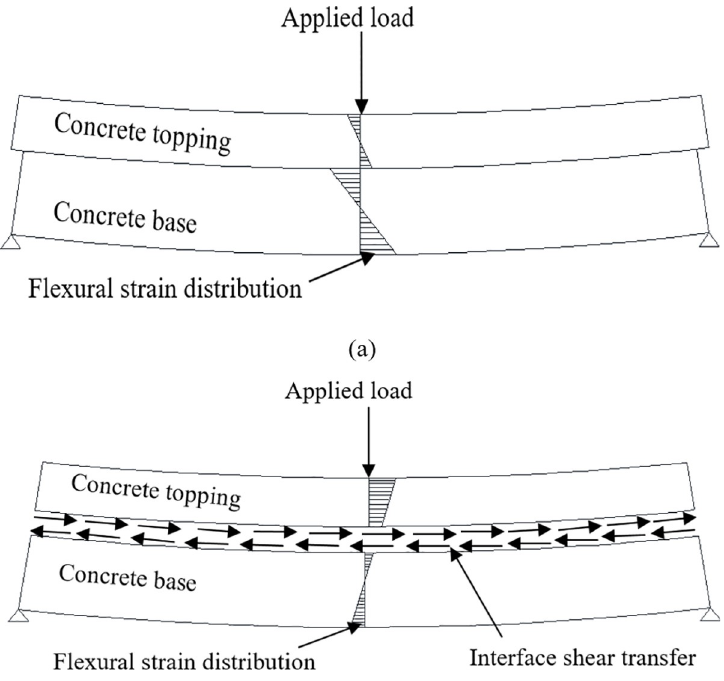
Fig 1. Stress distribution of a) Non-composite section and b) Composite section (Kovach and Naito